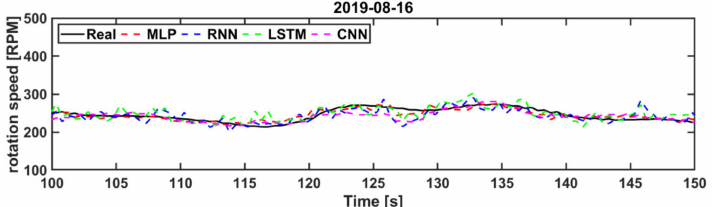
Figure 19. Detailed comparison of the prediction performances of each algorithm for the conditions of Case 5 (training datasets: 26 April 2019, 20 July 2019; test dataset: 16 August 2019).